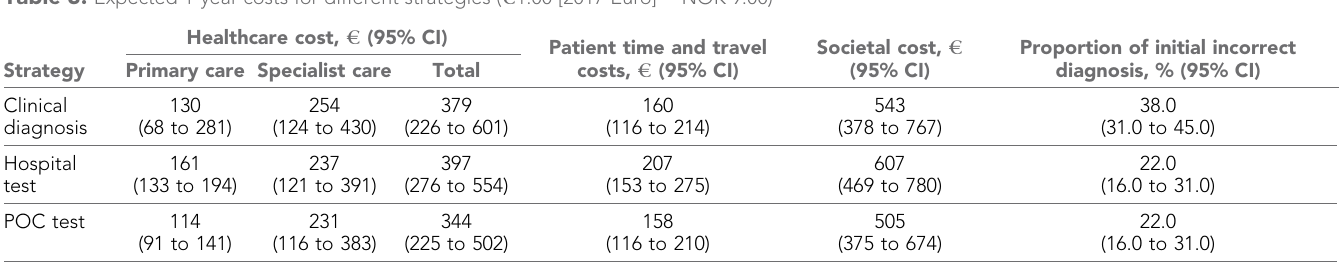
Table 3. Expected 1-year costs for different strategies ( e 1.00 [2017 Euro] = NOK